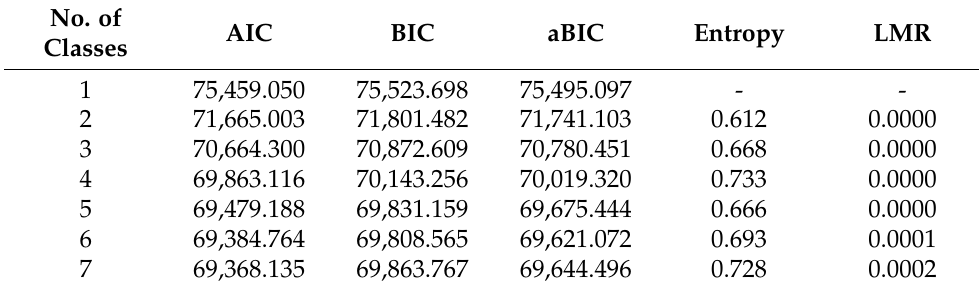
Table 5. Model fitting of vulnerable older adults.